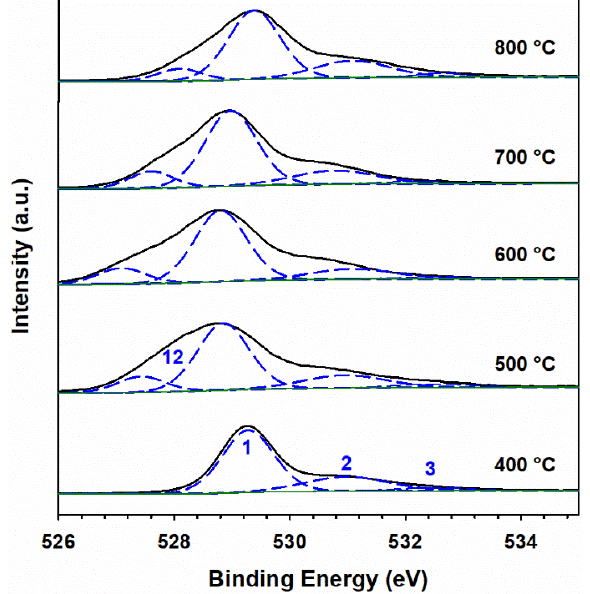
Figure 9. (Black trace) High-resolution XPS spectra of O 1 s for 100 Fe:5 K material, calcined at the temperature specified in each panel. (Dashed blue) Fitted peaks numbered (1) O 1 s for lattice iron oxides, (2) lattice hydroxyl, (3) surface hydroxyl, and (12) K–O bonded species. (Solid green) Fitted background.